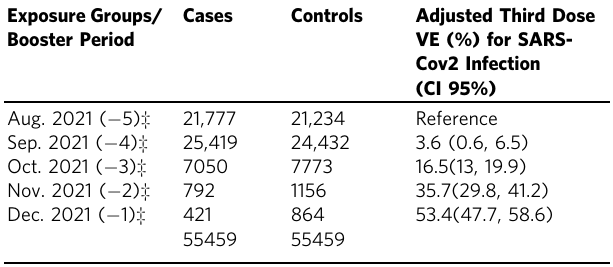
Table 2 Main analysis; adjusted Third Dose Effectiveness (VE) against SARS-Cov2 infection. Exposure Groups/ Booster